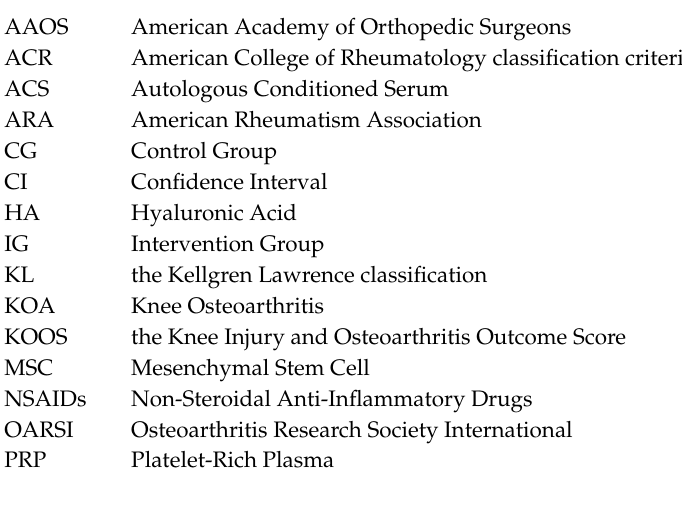
Figure S1: Subgroup analyses were performed based on di ff erent exercise type. (A) Tai Chi, (B) Baduanjin. Figure S2: Subgroup analyses were performed based on di ff erent geographical location. (A) Asian populations, (B) Non-Asian populations. Figure S3: Subgroup analyses were performed based on di ff erent duration time. (A) 8 weeks, (B) 12weeks. Figure S4: Subgroup analyses were performed based on di ff erent sample size. (A) No. of participants ≥ 30, (B) No. of participants < 30. Figure S5: Subgroup analyses were performed based on di ff erent control group type. (A) Active control group, (B) Passive control group. Table S1: Search strategy and result of each